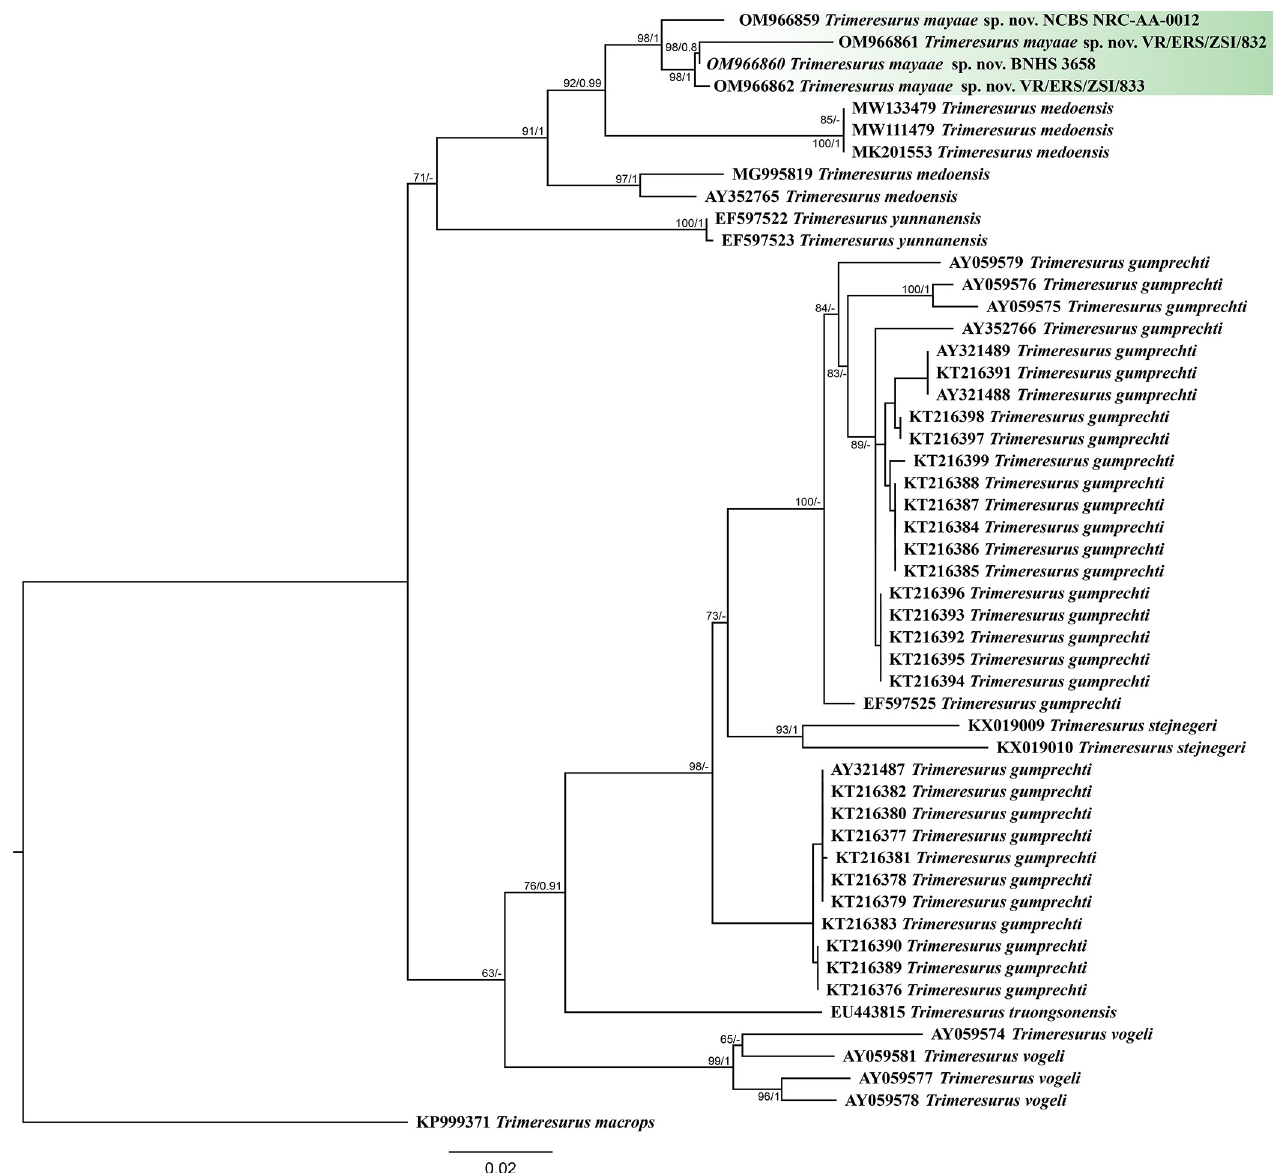
Fig 1. Maximum likelihood phylogeny of members of the subgenus Viridovipera . Numbers at nodes indicate ML bootstrap support through an ultra-fast search method. The outgroup has been remove, see S1 Fig for complete tree.